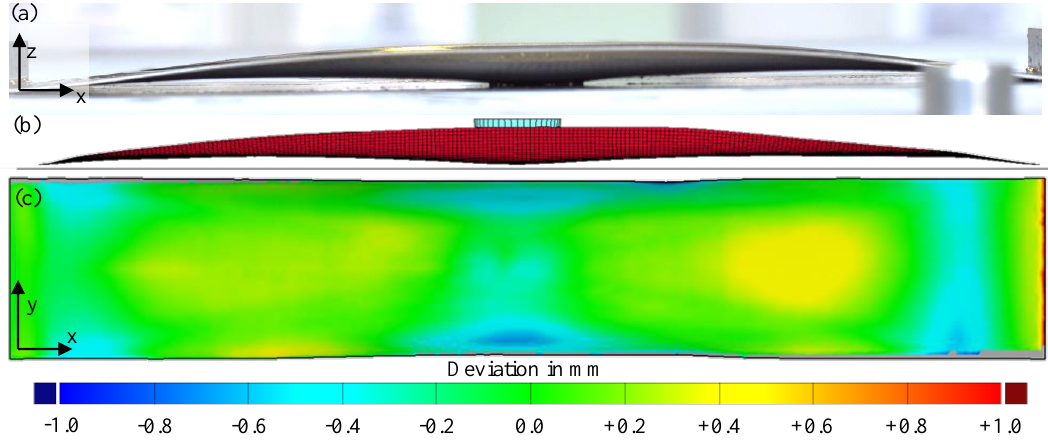
Figure 9. Side view of Pattern C for experimental ( a ) and simulation ( b ) results, both in the clamped state; and geometry comparison between experiment and simulation in top view ( c ).